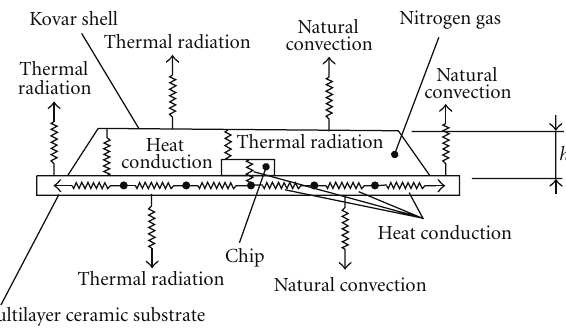
Figure 2: Cross-sectional view of the substrate.